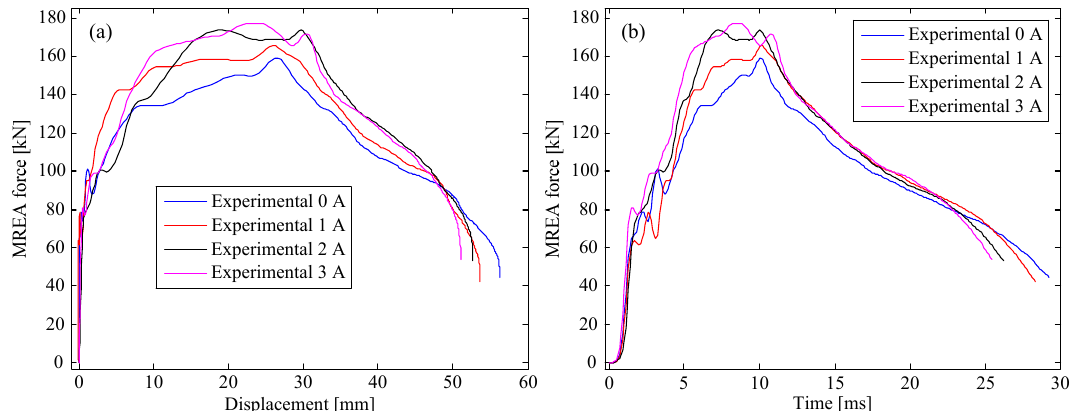
Figure 5. MREA performances at a drop height of 0.9 m: ( a ) force vs. displacement and ( b ) time history of the force.